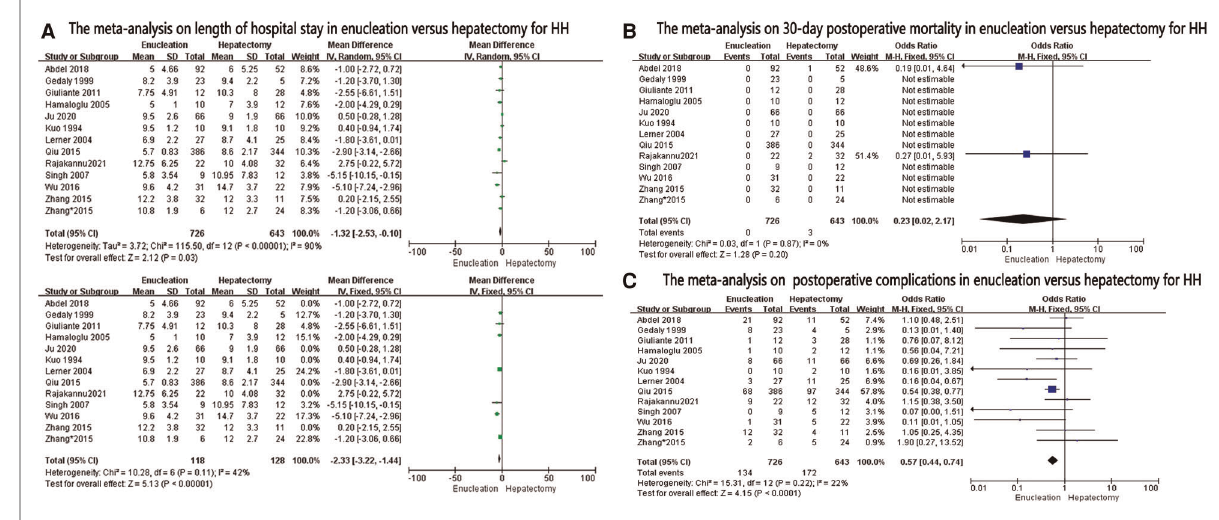
FIGURE 3 The forest plots for postoperative outcomes in enucleation versus hepatectomy for